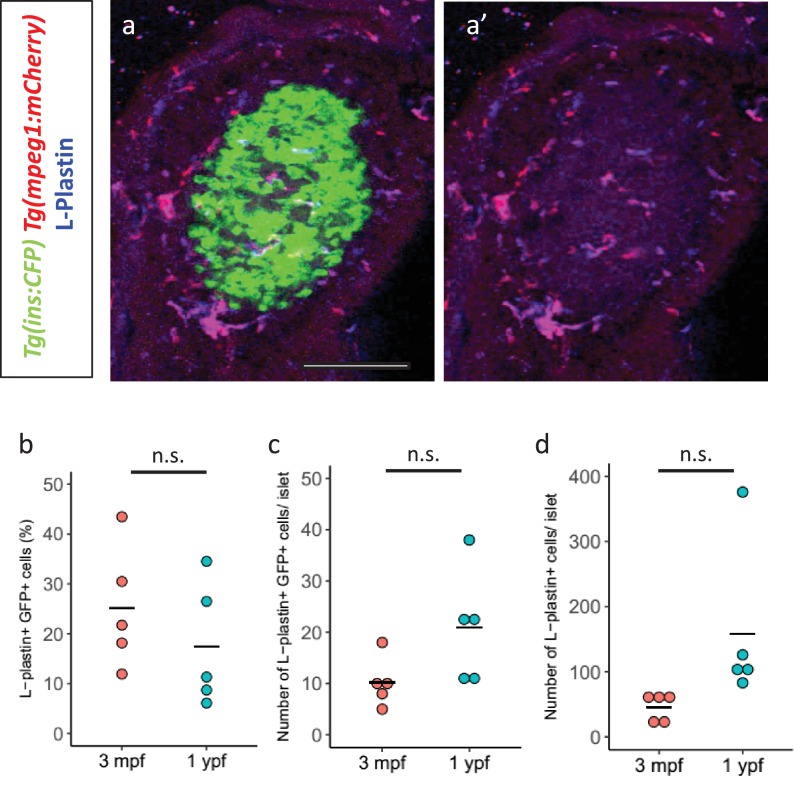
Immune cells infiltrate the islet during development.(a,a’) Confocal image of a juvenile islet. Tg(ins:CFP-NTR) line marks the beta-cells with CFP (green), leukocytes were labelled with the L-plastin antibody (blue) and Tg(mpeg1:mCherry) marks the macrophages (red). (b) Quantification of the percentage of TgBAC(tnfa:GFP) and L-plastin double-positive cells over the total number of L-plastin-positive cells in the islets of TgBAC(tnfa:GFP) animals at 3 mpf (n = 5) and 1 ypf (n = 5). Horizontal bars represent mean values (two-tailed t-test, p>0.05). (c) Quantification of the total number of TgBAC(tnfα:GFP)-positive and L-plastin double-positive cells at 3 mpf (n = 5) and 1 ypf (n = 5). Horizontal bars represent mean values (two-tailed t-test, p>0.05). (d) Quantification of the total number of L-plastin positivecells at 3 mpf (n = 5) and 1 ypf (n = 5). Horizontal bars represent mean values (two-tailed t-test, p>0.05).